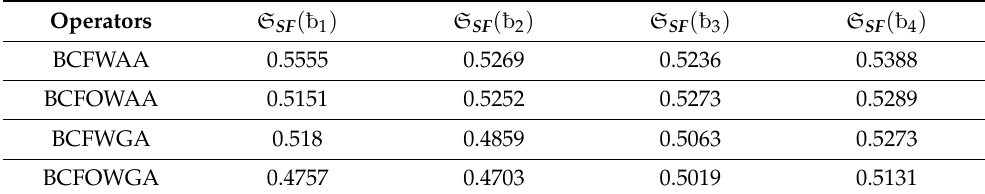
Table 7. Representation of the score values.